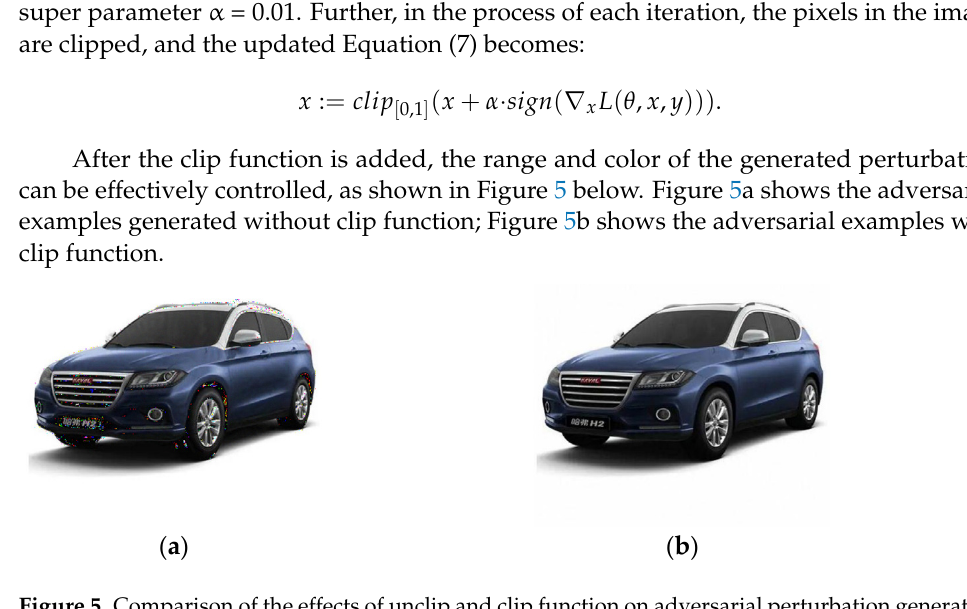
( d ) Figure 4. The morphology of the adversarial patches is generated by different algorithms. ( a ) Ad ‐ versarial Patch from our paper. ( b ) Universal Adversarial Patch. ( c ) Printable Adversarial Patch. ( d ) Dpatch. 4.3.2. Restricted Adversarial Perturbation Generation In this paper, the PGD algorithm is for reference, and the adversarial examples in the restricted area are generated after clipping based on the discussion of adversarial exam ‐ ples strategy in Ref. [6]. In a defense effect test, researchers set attack parameters through the white box, and the PGD algorithm is the only one that has stood the test. The algorithm randomly initializes the attack data in the image range and generates adversarial infor ‐